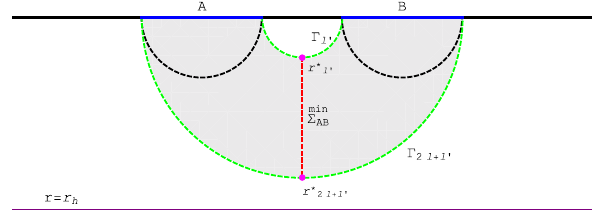
Fig. 1 The gray region shows the entanglement wedge dual to ρ AB . The minimal surfaces, RT-surfaces, are denoted by (cid:5) , the dashed curves where (cid:8) x ≡ ( x 1 , ..., x d ) . The above metric is asymptotically AdS d + 2 and r is the radial direction. The strongly coupled field theory lives on the boundary at r → ∞ . f 1 , f 2 and f